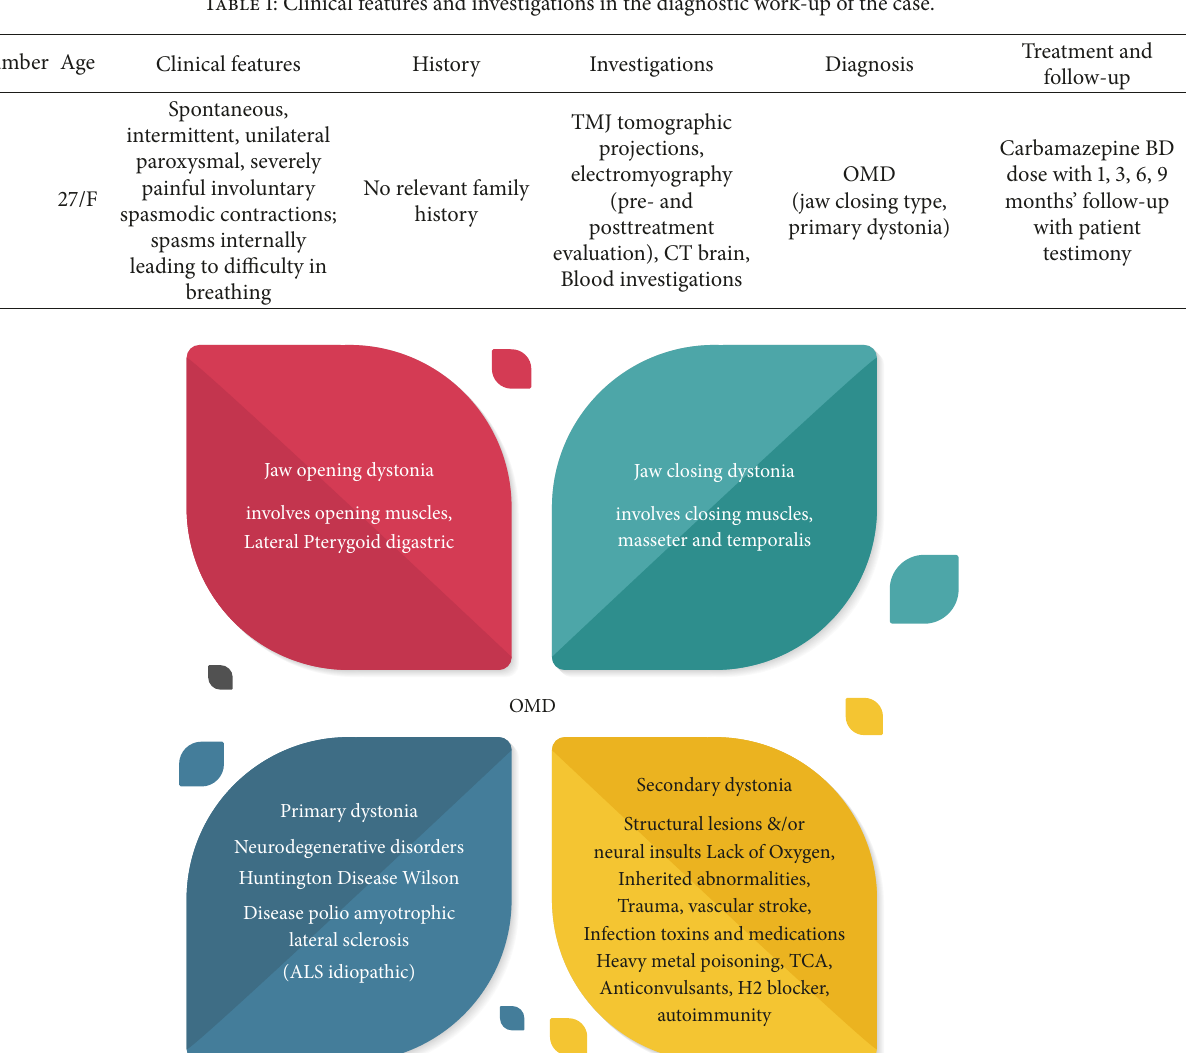
Figure 6: Classification of oromandibular dystonia based on